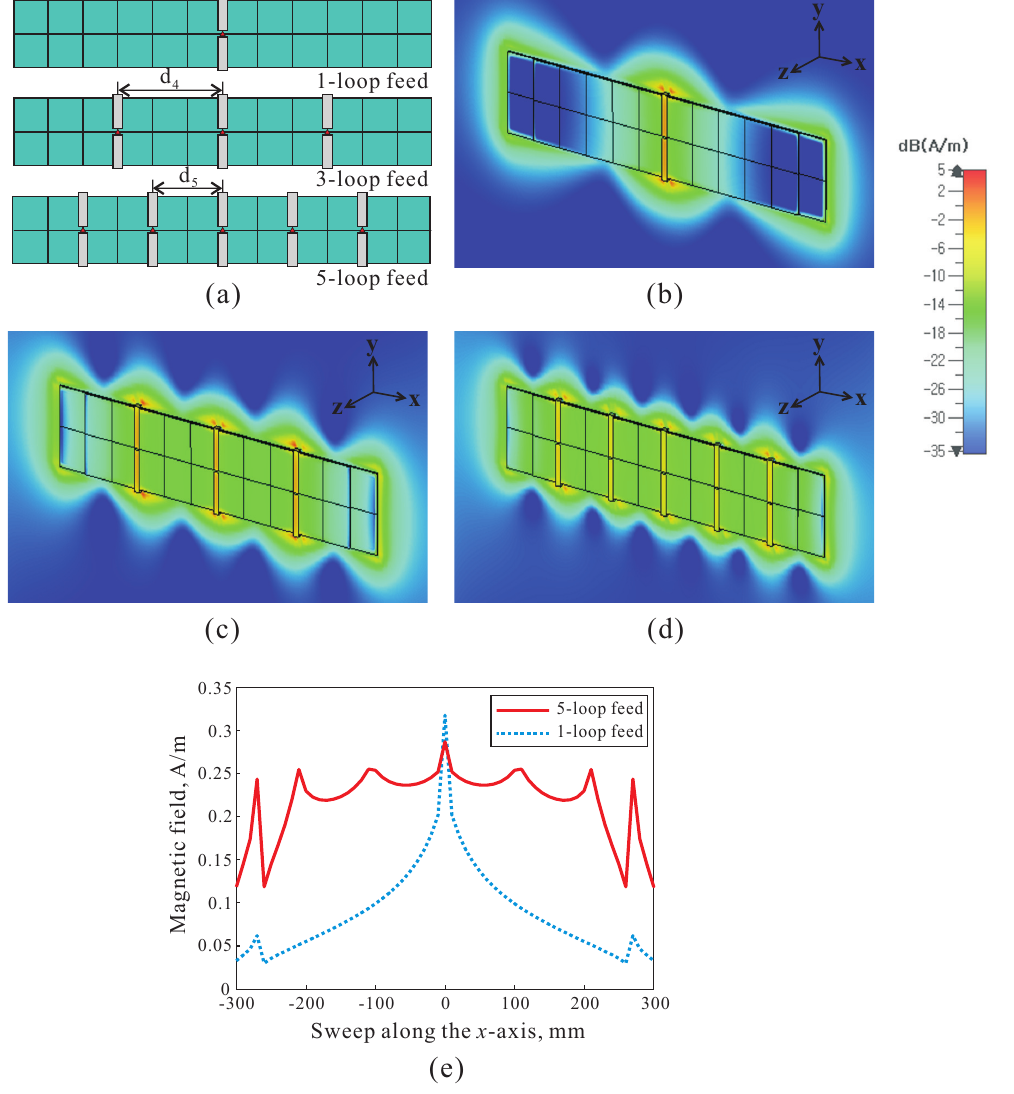
Figure 3. Magnetic field distribution of the ferrite dipole antenna at 150 MHz. ( a ) Geometry of the antenna with different numbers of loop feeds: ( b ) 1-loop feed, ( c ) 3-loop feed, ( d ) and 5-loop feed. ( e ) Simulated magnetic field distribution along the length of the